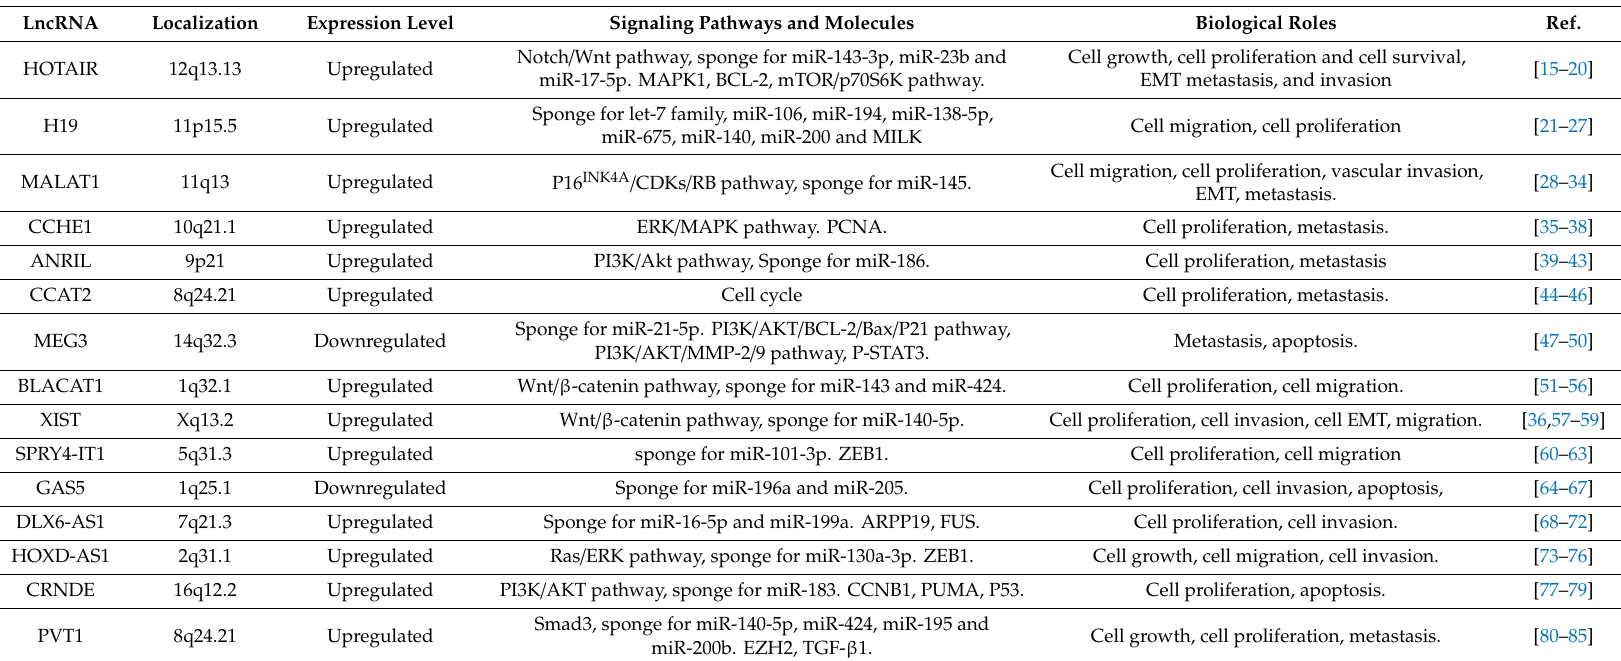
Table 1. lncRNAs and their mechanisms and biological roles in Cervical cancer